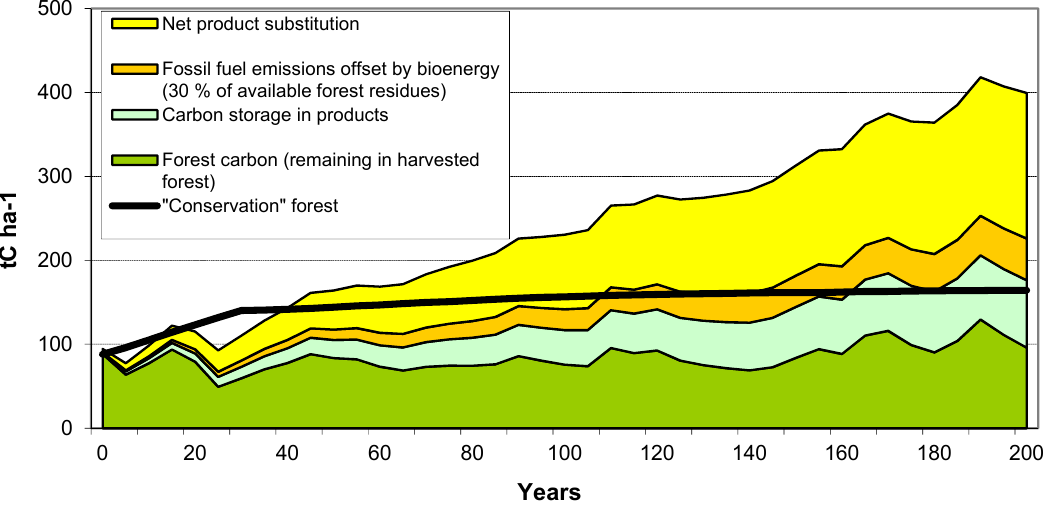
Figure 8. Greenhouse gas (GHG) implications of the “ conservation ” and “ production